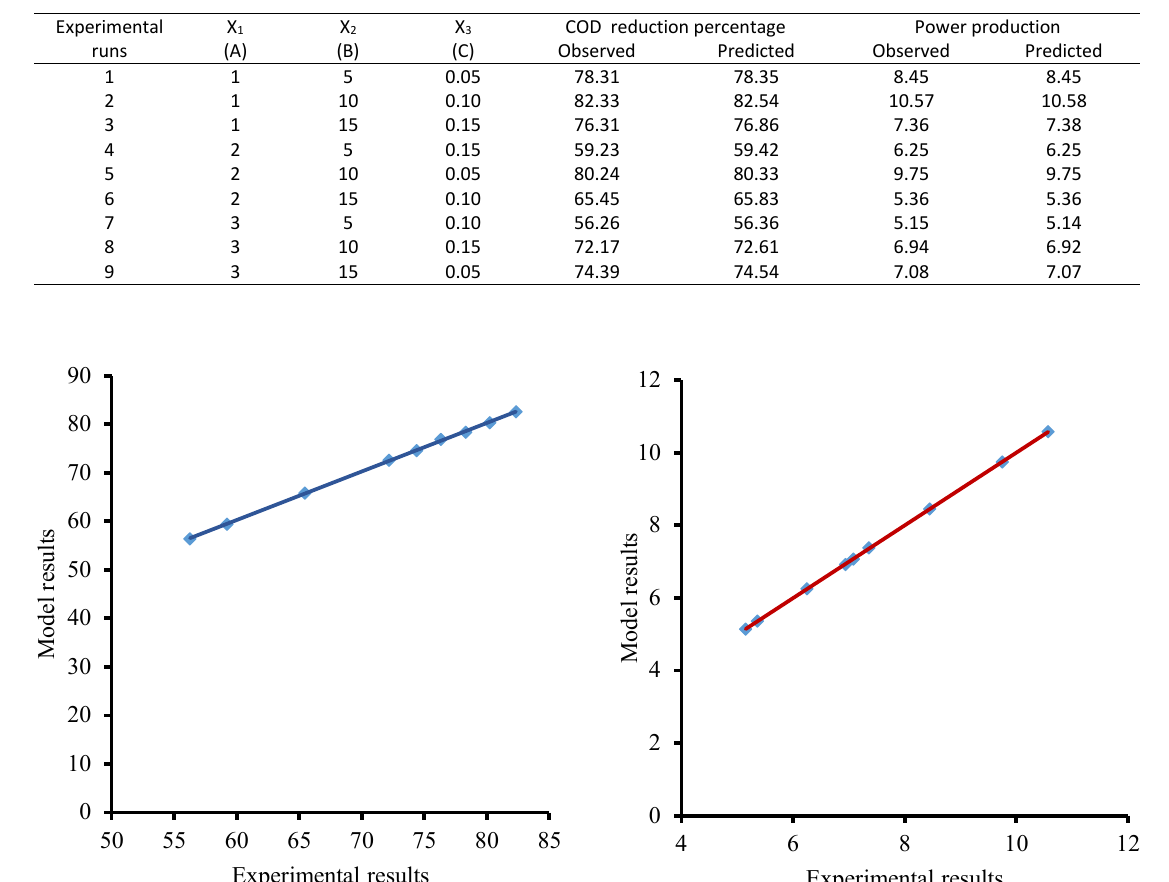
Fig.12: Relationship between experimental and model results of power production